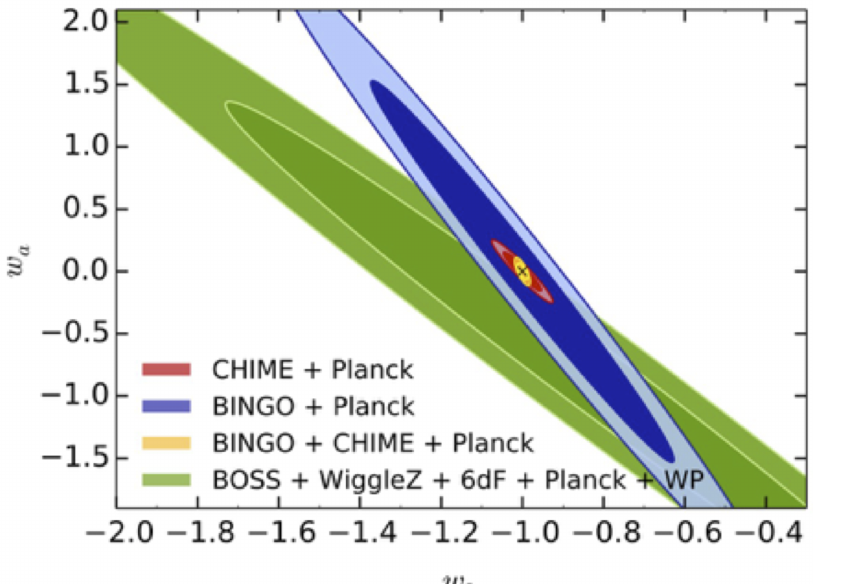
Figure 1. Constraints on DE equation of state, including forecasts from CHIME and BINGO. Note the tight error elipse obtained with combined radio data (BAO from CHIME and BINGO +